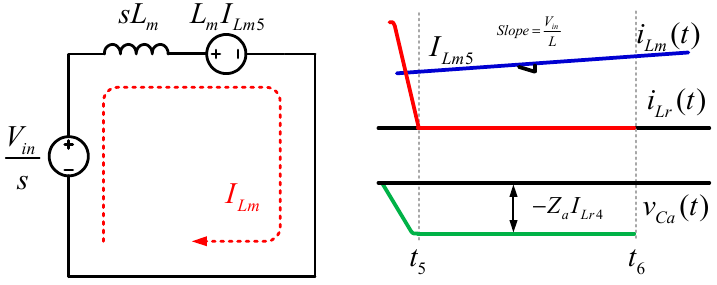
Figure 9. The equivalent circuit of Mode 6 and key waveform.